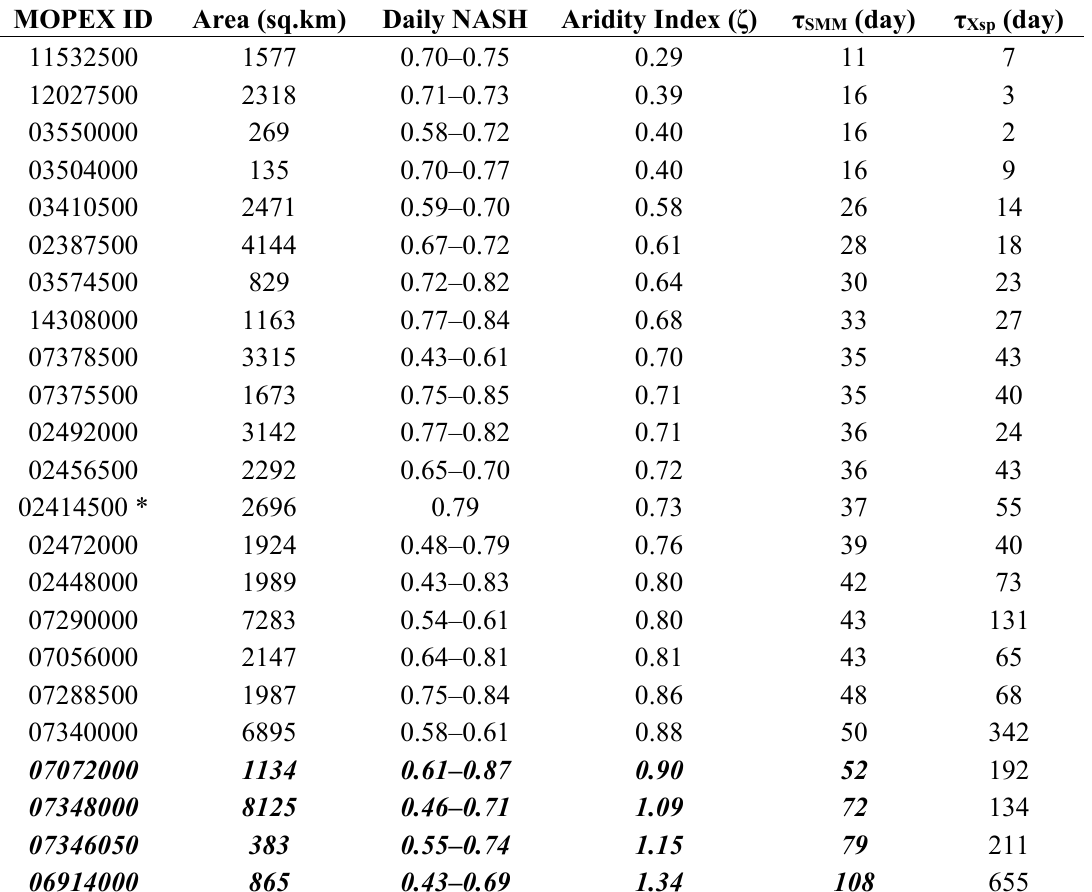
Table 4. Summary of the XAJ model spin-up time